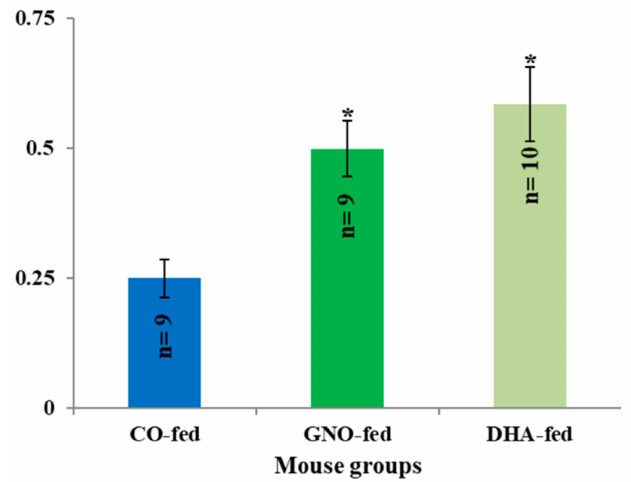
Figure 5. E ff ects of GNO and DHA on memory e ffi ciency of SAMP8 mice. All data are presented as mean ± SEM. n indicates the number of mice, and * indicates p < 0.05 compared to CO-fed SAMP8